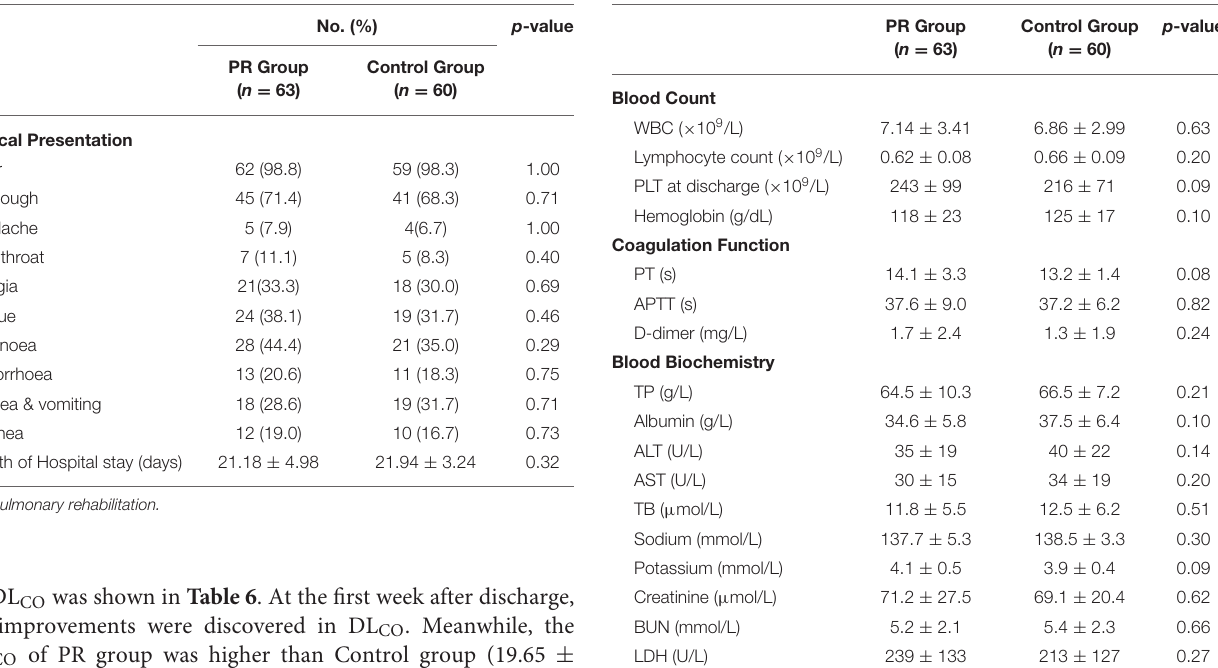
TABLE 2 | Clinical characteristics in PR and control groups. TABLE 3 | Results of laboratory examination at